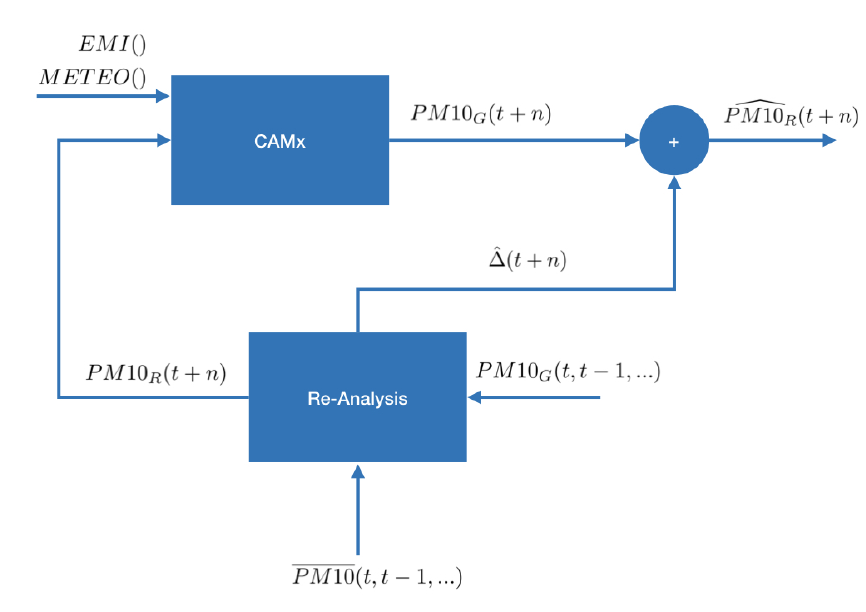
Figure 1. Diagram of the implemented